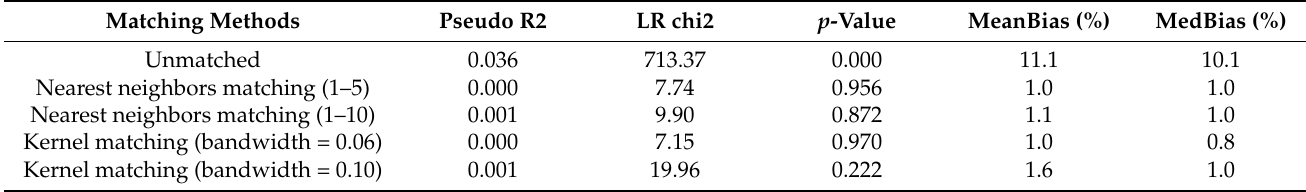
Table 11. Balancing test results for independent variables before and after matching (outcome variable: Recent illness).